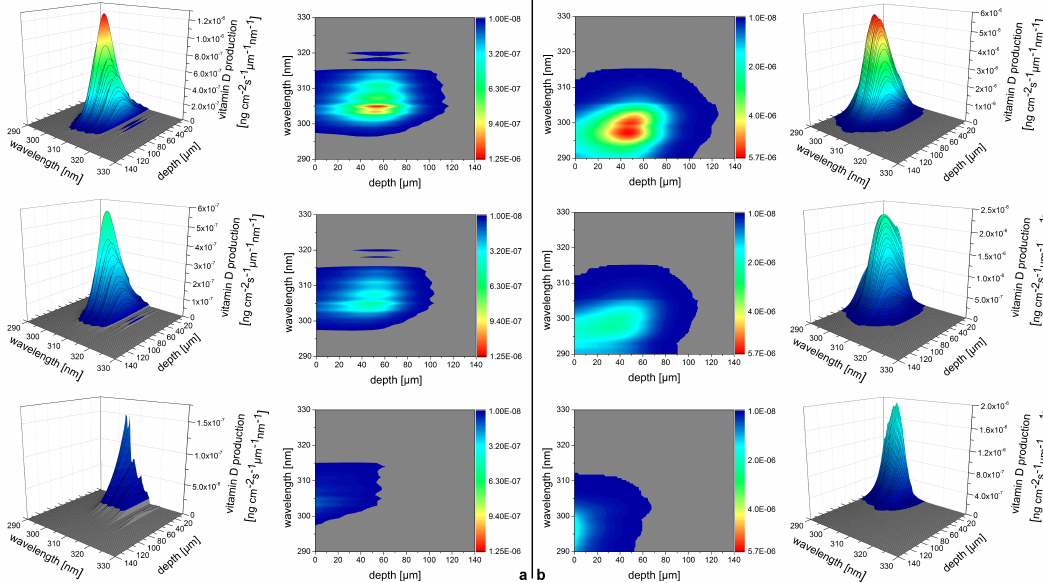
Figure 27. Modeled previtamin D photoproduction. Production by solar irradiation is shown in 3D and as contour plots at the left side ( a ), production from a TL12 “fluorescent sun” lamp is shown on the right side ( b ). Different skin sites are shown: inner side of forearm ( top row), outer side of forearm ( middle ), ball of the thumb ( bottom row). The color-coding scale is different for TL-12 and solar irradiation but consistent within each group (reproduced with permission from [139]).